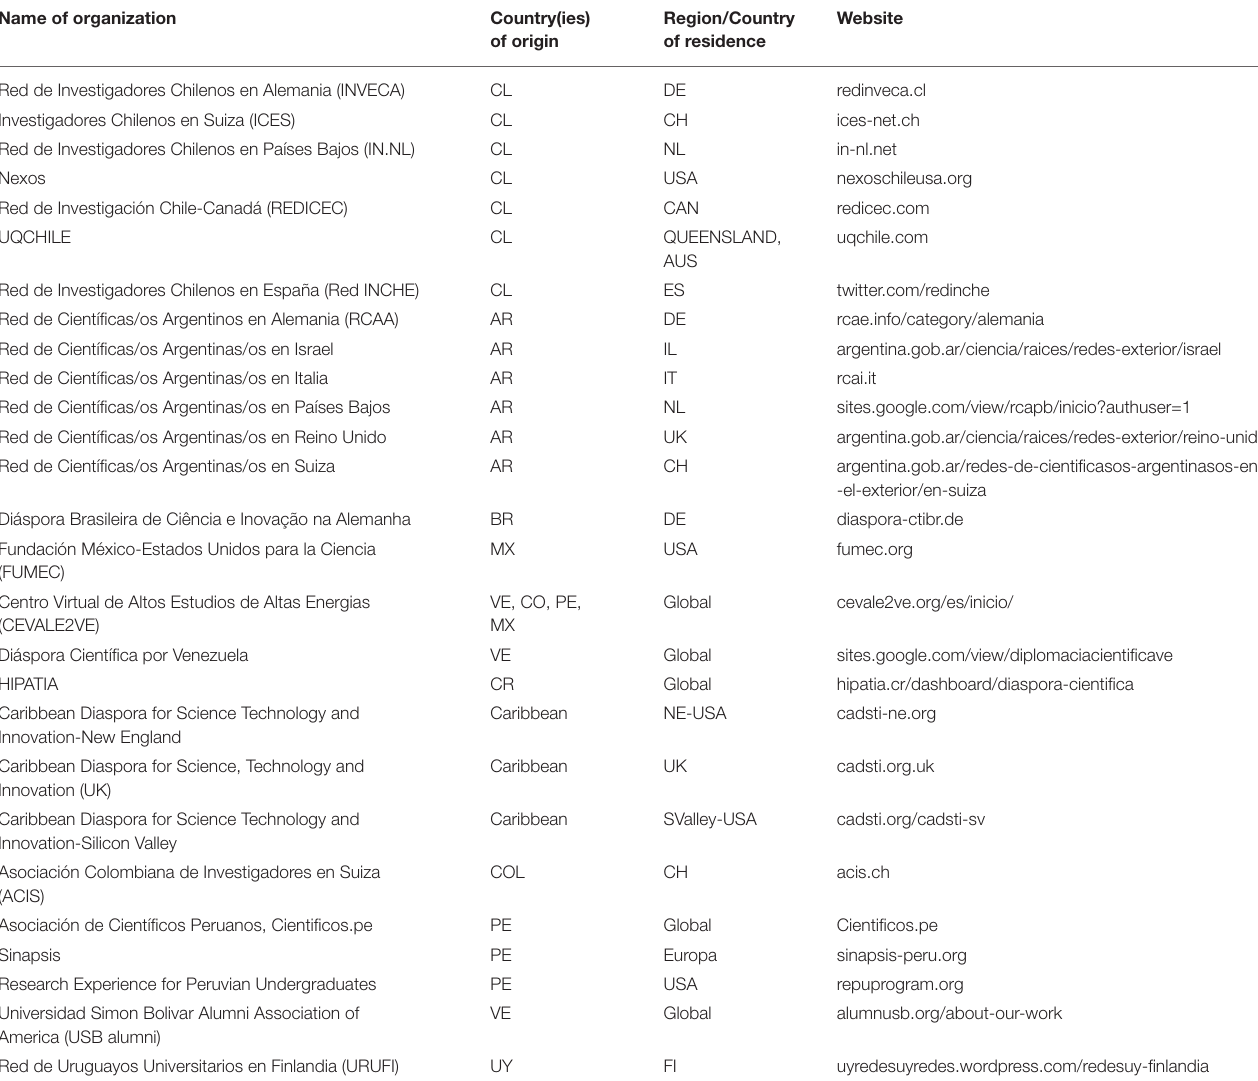
TABLE 2 | List of Latin American and Caribbean scientific diaspora organizations